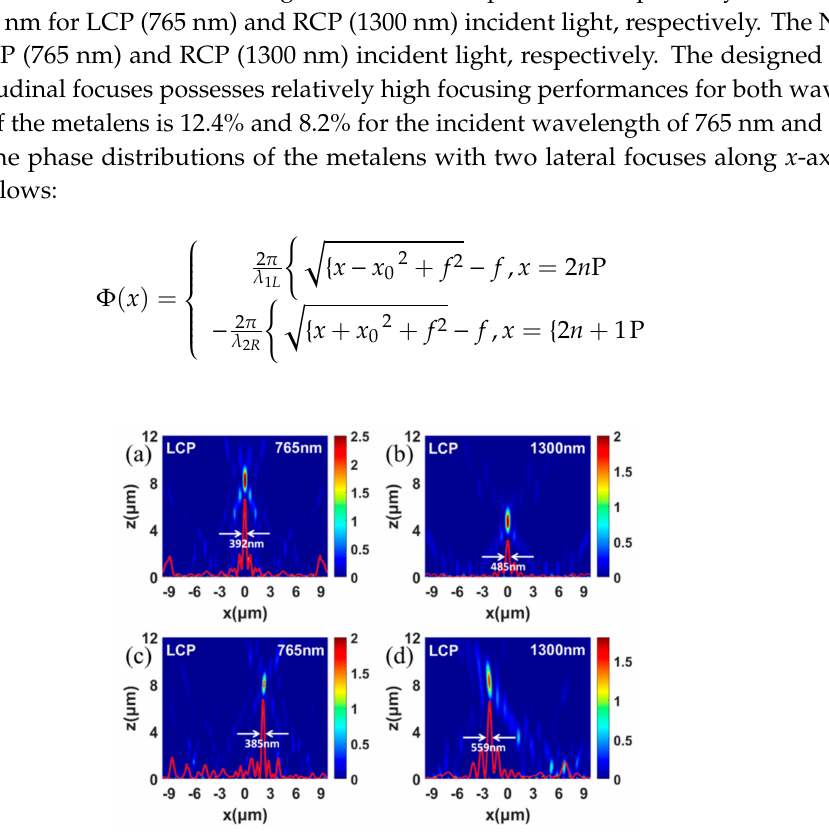
Figure 4. Simulated intensity distributions in the X–Z plane of the designed spin-selected dual-wavelength metalens with the focus displacement along vertical direction under the LCP incidence of 765 nm ( a ), RCP incidence of 1300 nm ( b ). Simulated intensity distributions in the X–Z plane of spin-selected dual-wavelength metalens with the focuses displacement along lateral direction under the LCP incidence of 765 nm ( c ), RCP incidence of 1300 nm ( d ). The red curves show the concrete profiles of the FWHMs of the